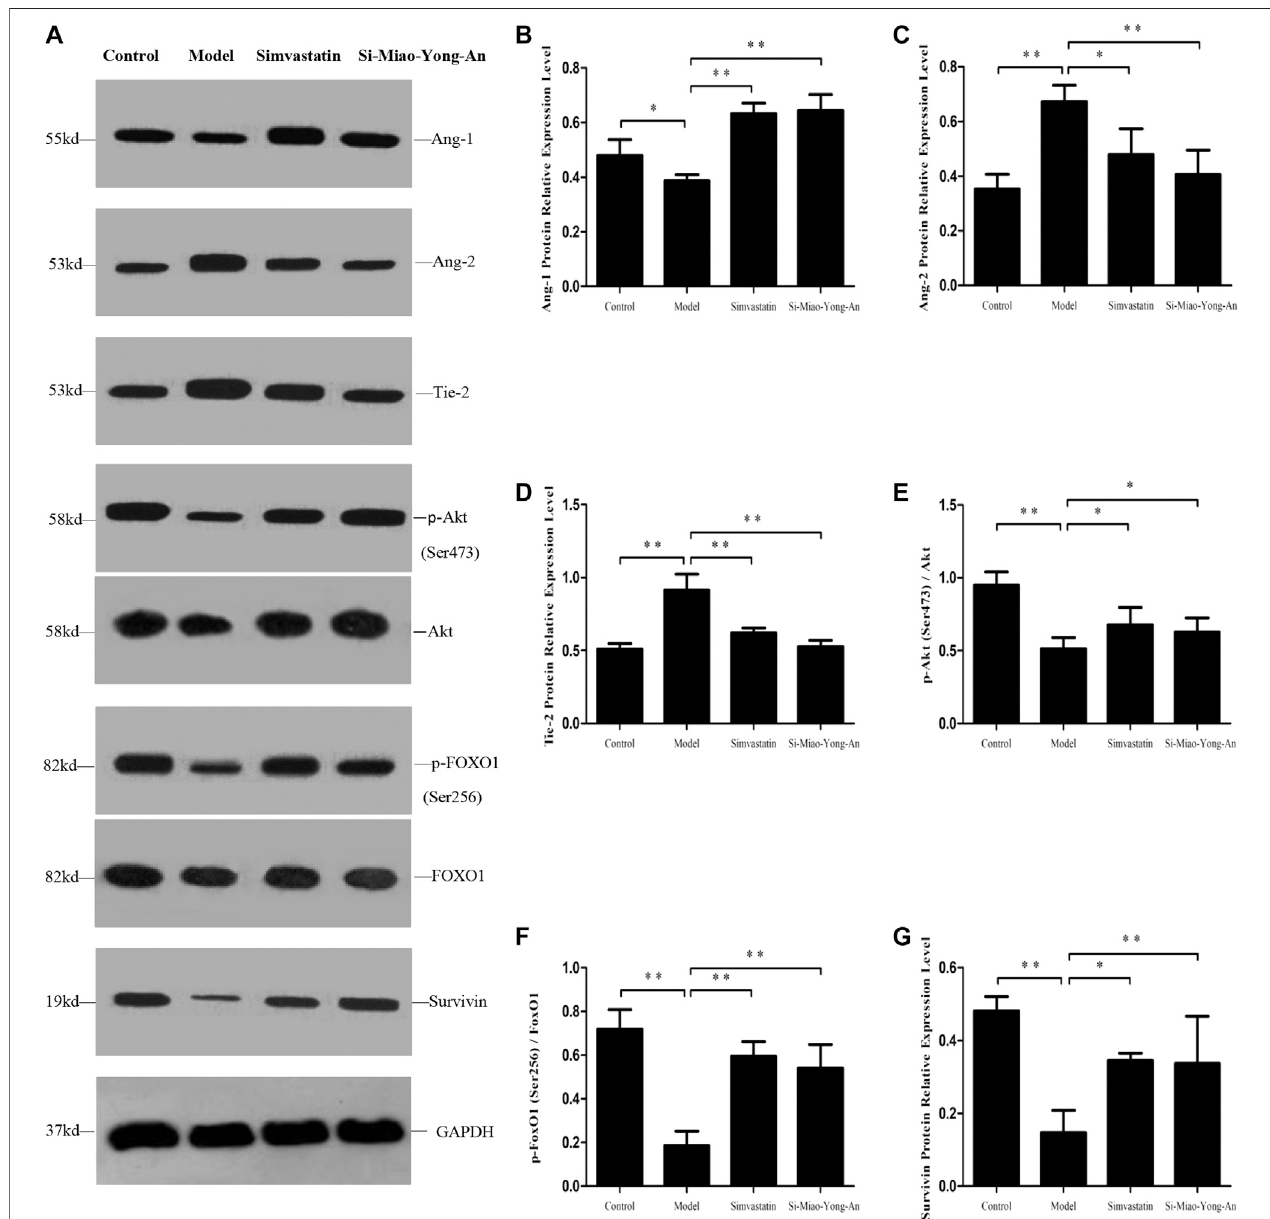
FIGURE 8 | Effect of SMYA on Ang-1/Tie Signal Pathway. (A) Western blot was applied to detect the key proteins of Ang-1/Tie signal pathway in aorta of each group. B – G: Semi-quantitative analysis of the results. *p < 0.05, **p < 0.01.